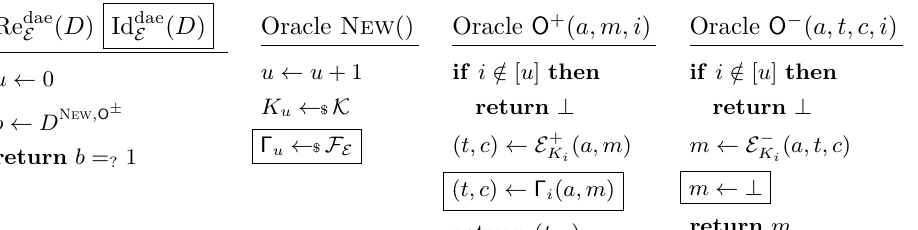
Figure 2.5: Deterministic authenticated encryption game, where F E = F ( A × M , T × M ). In order to avoid trivial wins, the adversary is not allowed to query oracle O − with an answer he received from a query to O +